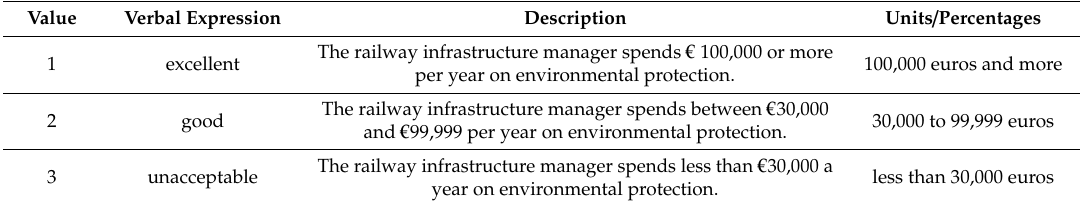
Table 3. Indicator—Amount of investments aimed at environmental protection.